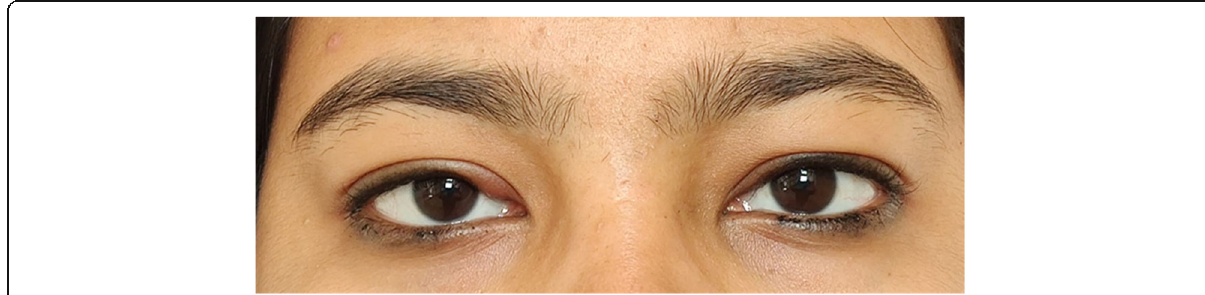
Fig. 2 View of the eye showing nodular swelling at the medial margin of the upper lid of the right eye with normal anterior segment after 1 week of performing the dental procedure (Recurrent infection)